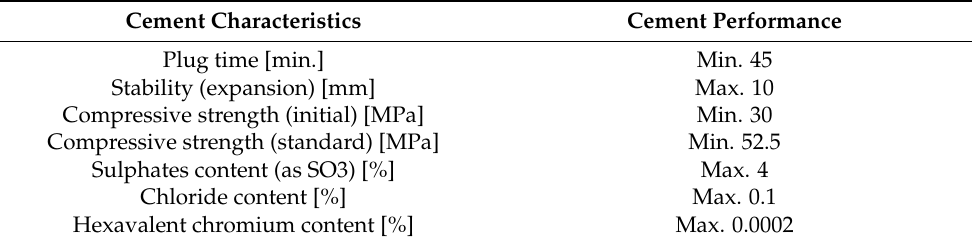
Table 1. Essential characteristics and performance of cement.